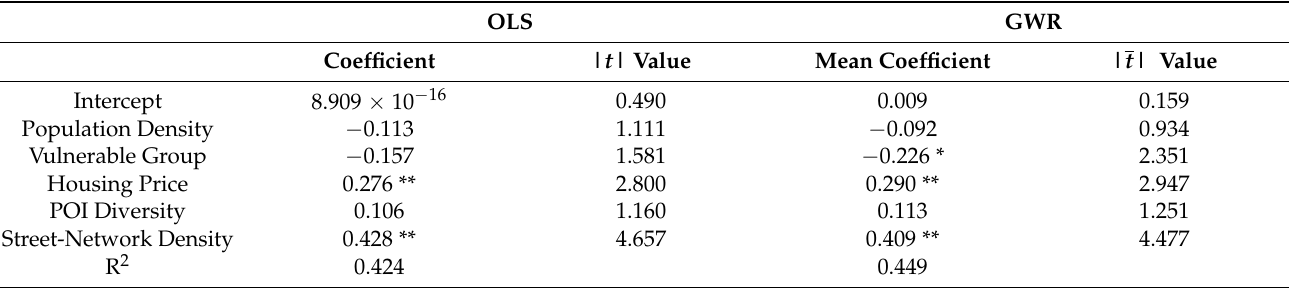
Table 5. OLS and GWR analyses of green view.